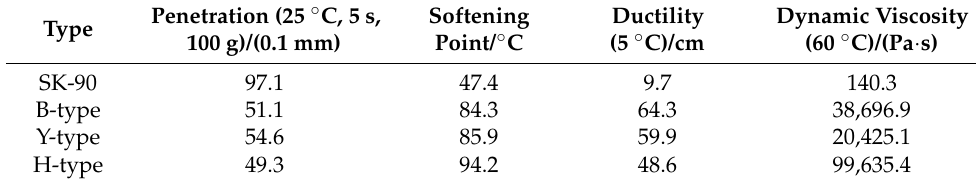
Table 2. Characteristics of asphalt